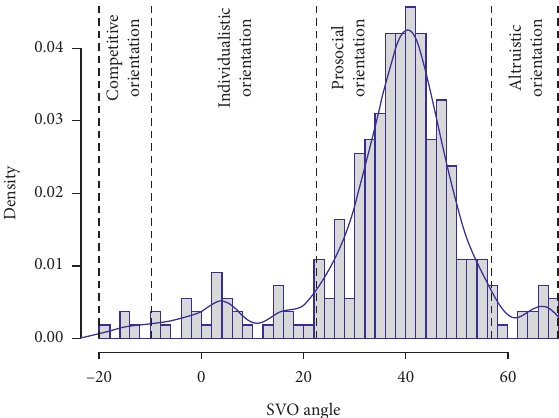
Figure 5: Diagram of SVO angle distribution.